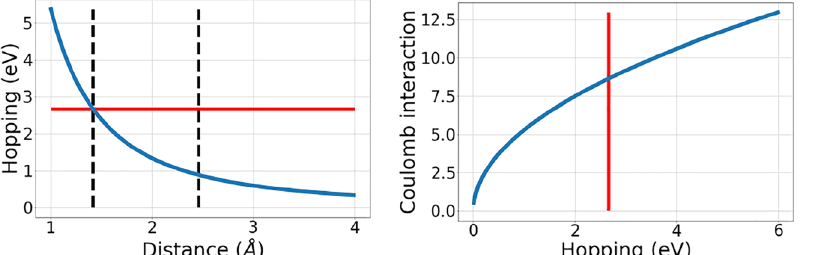
Figure 13: Left: Hopping parameter t 𝛼 between the adatom and the nearest carbon atom site as a function of the distance between them. Right: Coulomb interaction as a function of the hopping parameter. The black dashed lines are located at distances related to the graphene √ 3 ≈ 1 . 42Å) and the lattice constant (smallest distance between two structure: the distance between nearest atoms in graphene (2 . 46Å ∕ atoms that belong to the same sublattice, at 2.46 Å ). The red lines are located at the hopping value for pure graphene: t = 2.66